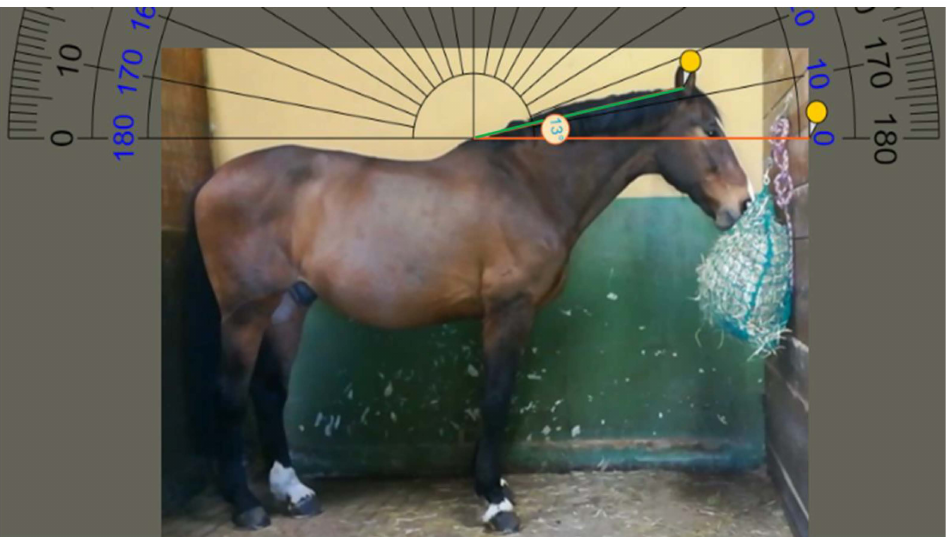
Figure 5. High hay net position (HP): angle formed between the green line running from the withers to the poll of the neck and the reference line crossing the withers and parallel to the ground.